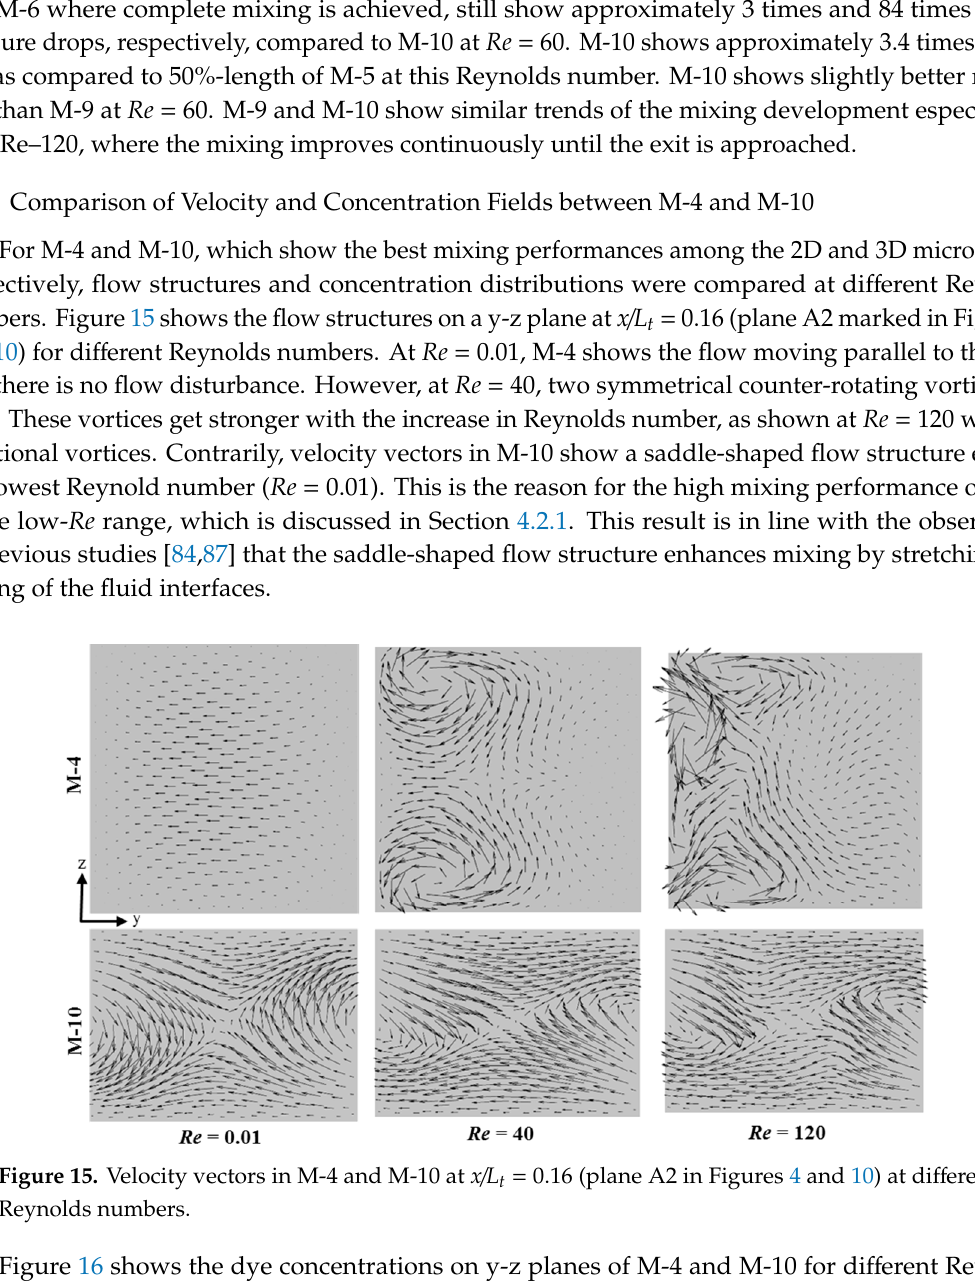
Figure 16. Dye concentration distributions at different Reynolds numbers: ( a ) M ‐ 4; and ( b ) M ‐ 10.